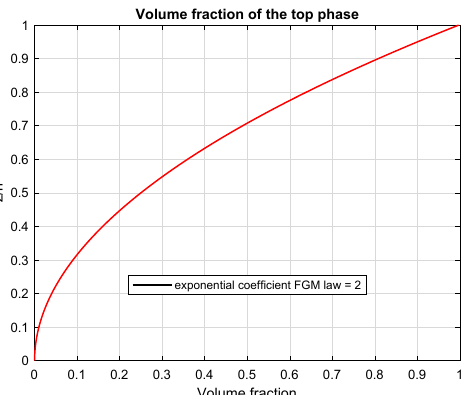
Figure 11. Fourth benchmark, volume fraction of the ceramic phase for a simply supported spherical shells with one FGM ( p = 2)